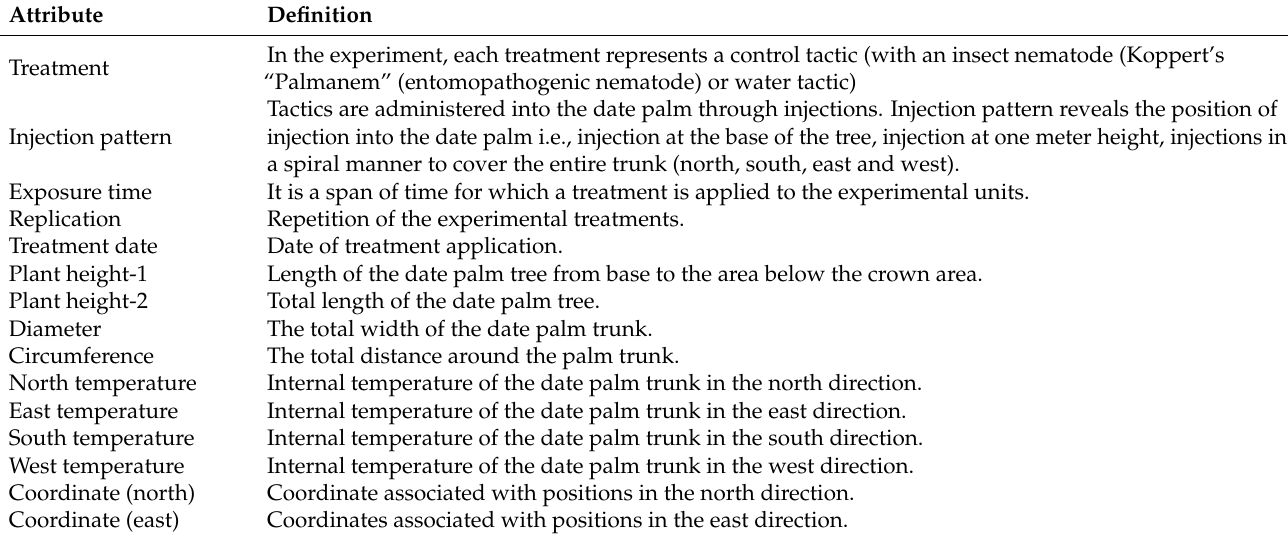
Table 1. Descriptions of the dataset